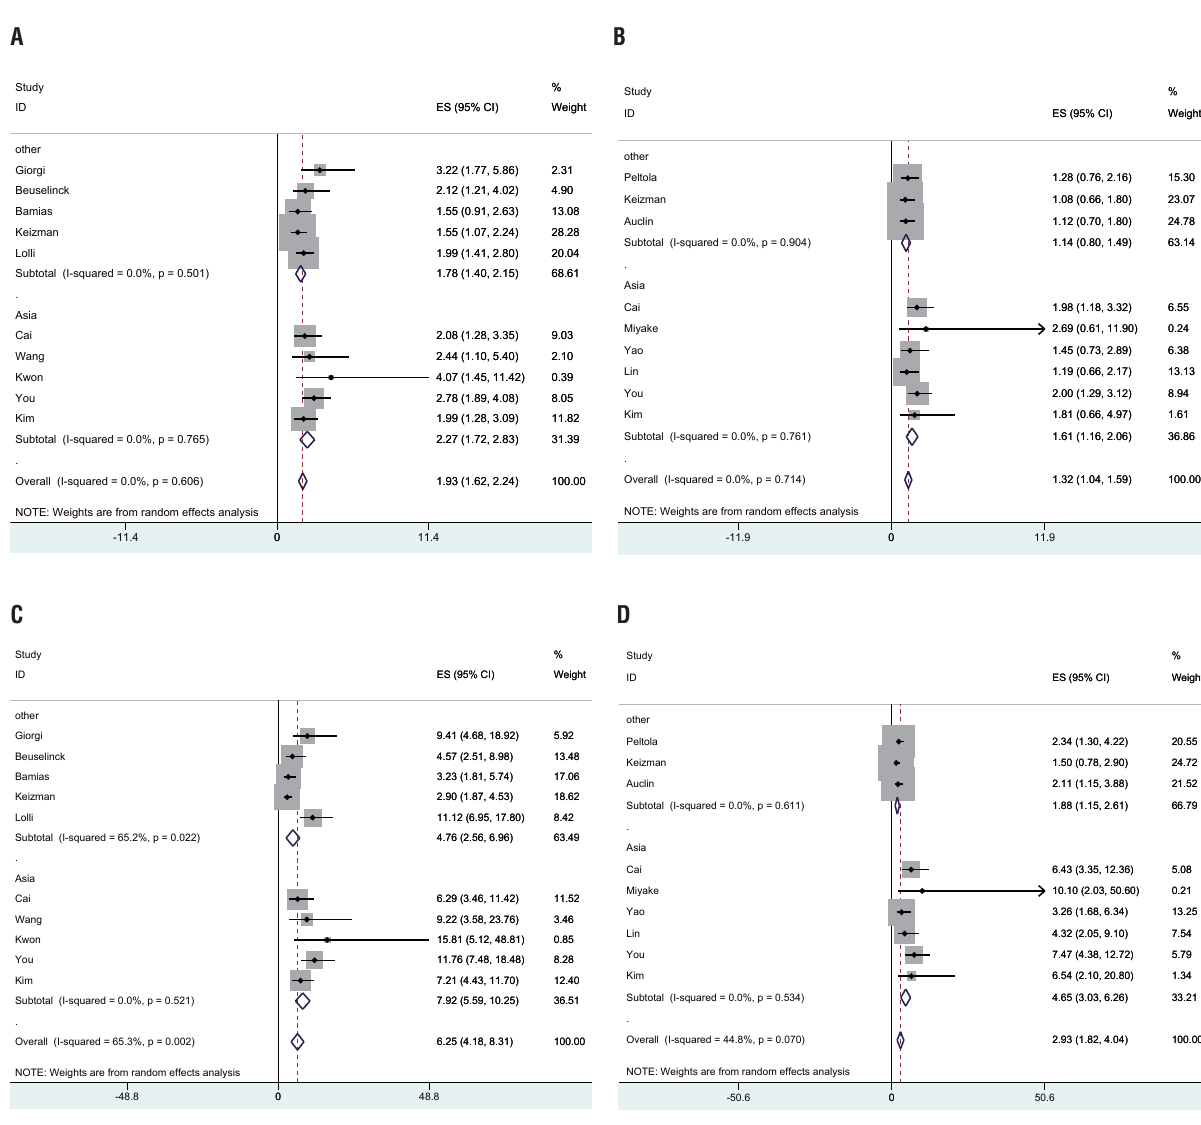
Supplementary Figure 3 - Subgroup analysis of area for